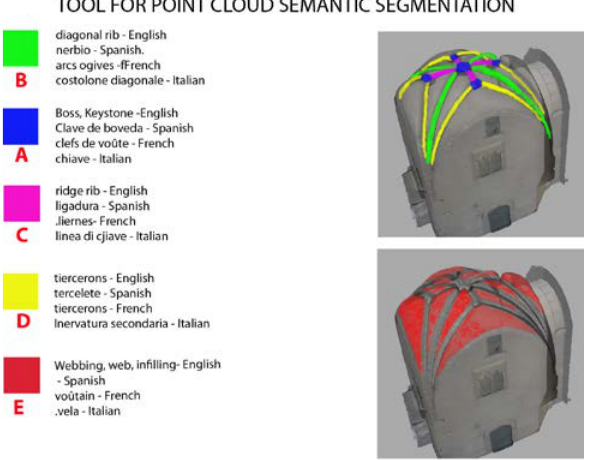
Figure 15 . Point cloud sematic segmentation